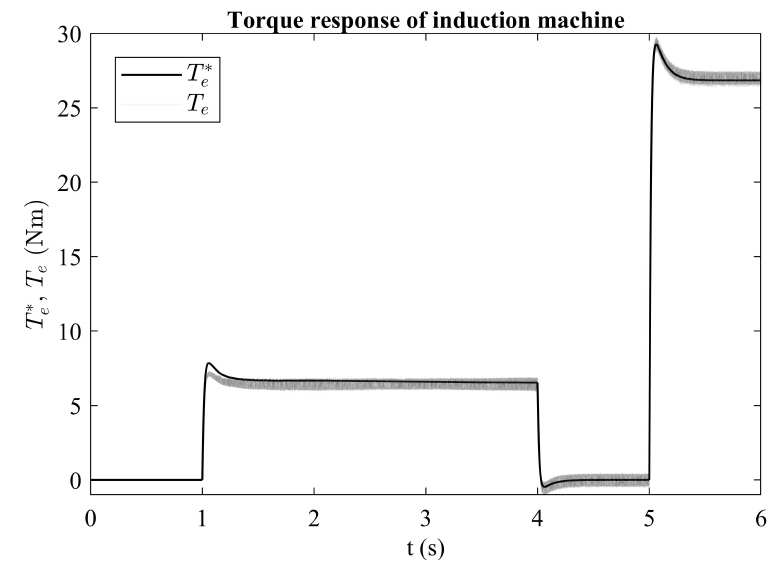
Figure 7. Commanded and generated torque